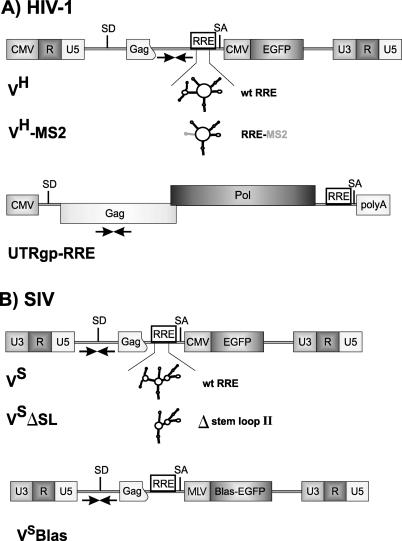
Map of HIV-1 and SIV Vector ConstructsOpposing arrows mark primer binding sites for the quantitative real-time PCR. Predicted secondary structures for wild-type (wt RRE) and mutated RRE are shown, with the grey stem loop representing the MS2-derived RNA motif. (A) HIV-1 vector constructs, (B) SIV vector constructs.Blas-EGFP, EGFP cDNA fused in frame to the Blasticidin resistance gene; CMV, human cytomegalovirus immediate early promoter; EGFP, gene for the enhanced green fluorescent protein; MLV, murine leukemia virus promoter; R, direct repeat sequence; SA, splice acceptor; SD, splice donor; U3, 3′ unique sequence; U5, 5′ unique sequence.